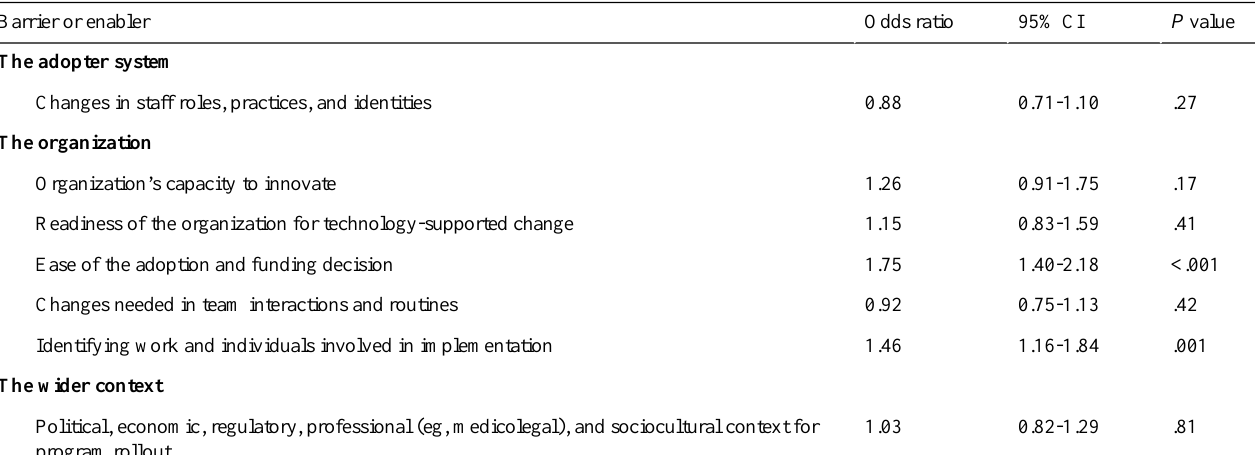
Table 4. Nonadoption, abandonment, scale-up, spread, and sustainability subdomains associated with high intentions to adopt digital health interventions in early childhood education and care